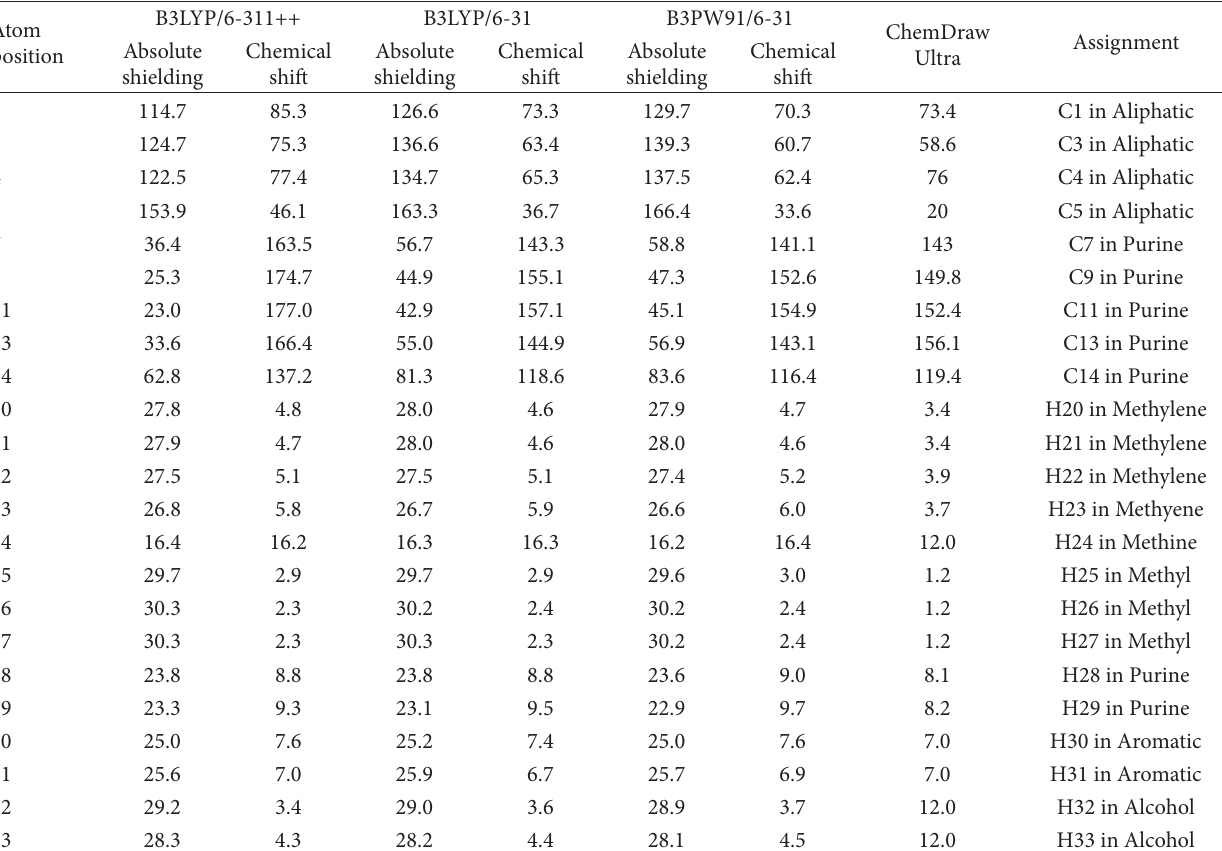
T 6: e calculated 13 C and 1 H NMR chemical shis of tenofovir.